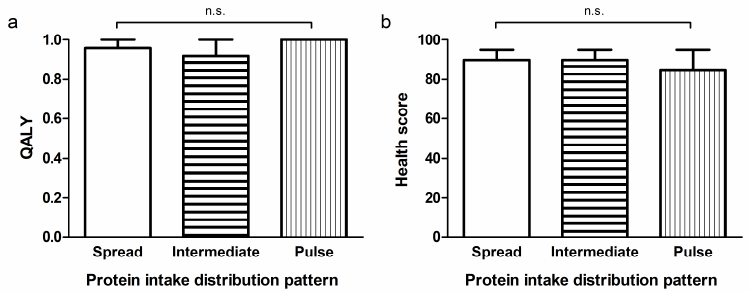
Figure 4. QALY (Quality-Adjusted Life Year) ( a ) and health score ( b ) of 3 groups based on distribution pattern of protein intake during the main meals determined with CV (coefficient of variance). Participants in the spread group ( n = 46, CV < 0.43), intermediate group ( n = 48, CV 0.43–0.62) and pulse group ( n = 46, CV > 0.62) had similar QALY and health scores. N.s., not significant. Data are presented as means ± SDs.